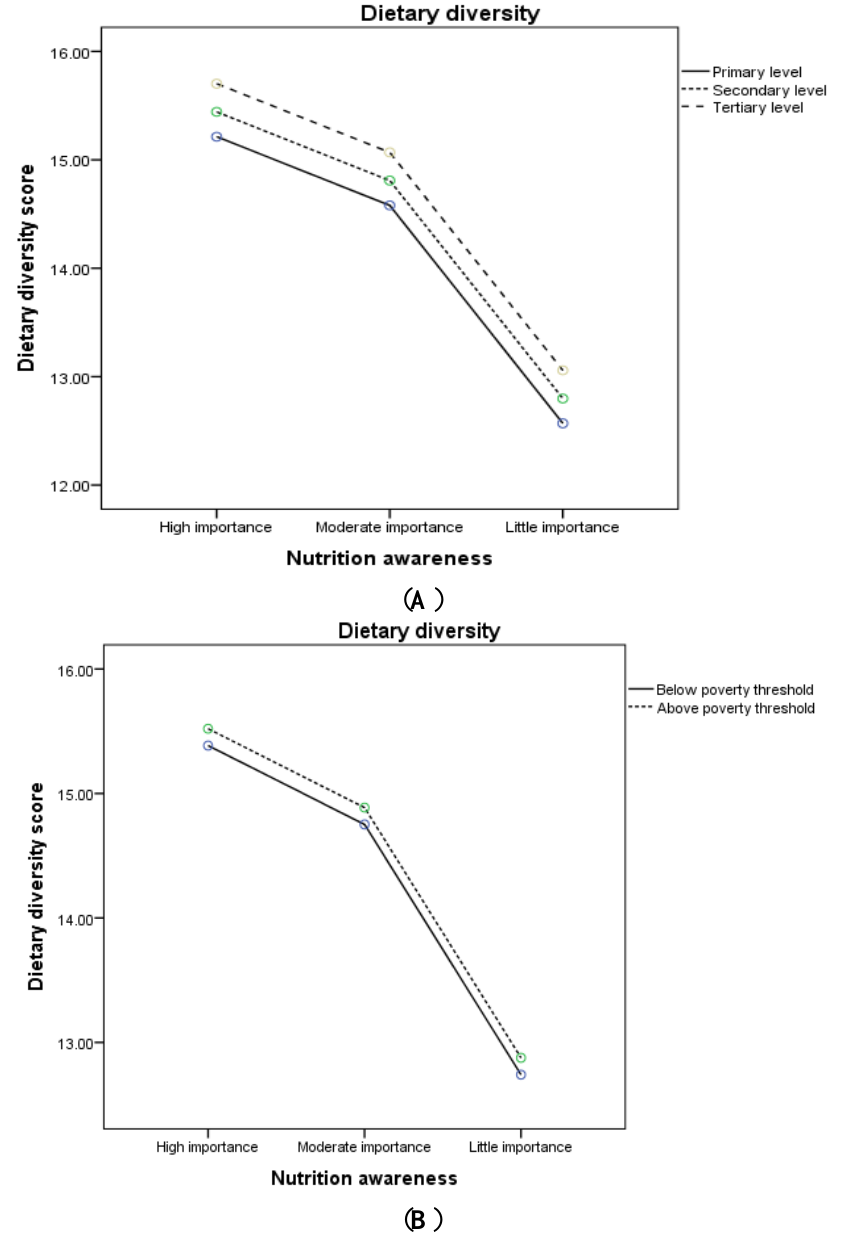
Figure 2. Covariate-adjusted mean * of dietary diversity score across levels of nutritional awareness by ( A ) education level (* adjusted for age, sex, country of birth, BMI, income, and total energy intake); ( B ) household poverty threshold (* adjusted for age, sex, country of birth, BMI, education level, and total energy